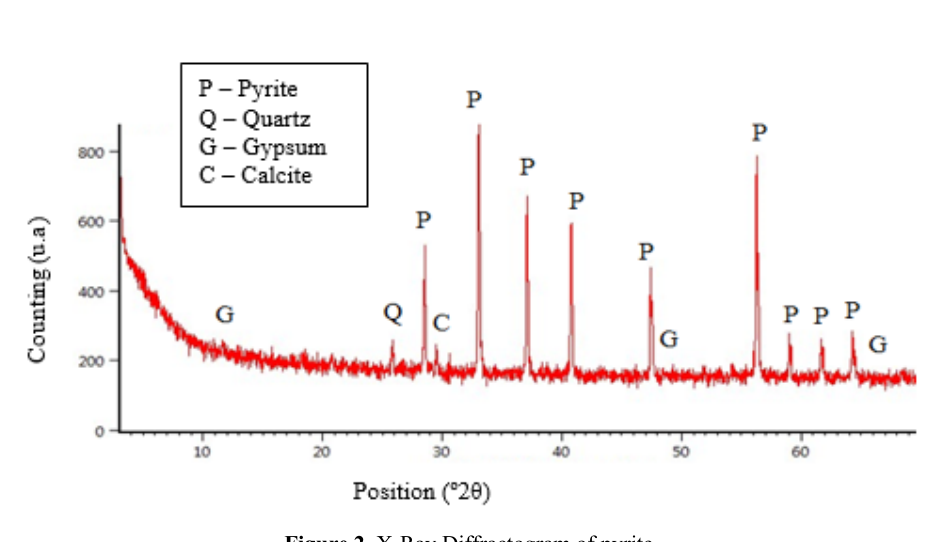
Figure 2. X-Ray Diffractogram of